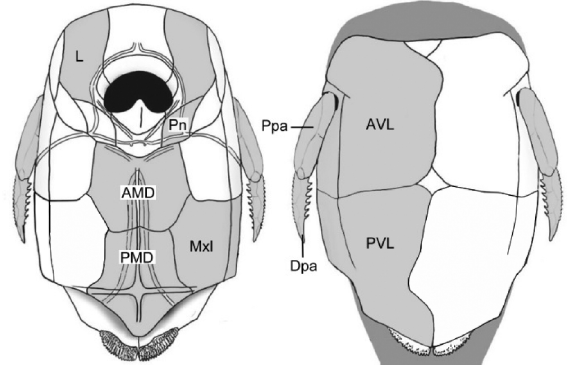
Fig. 2. Microbrachius dicki restoration (modified from Long et al. 2015, fig. 3a, b) with light grey shaded areas to indicate the known plates of Microbrachius kedoae . Abbreviations: AMD, anterior median dorsal plate; AVL, anterior ventro- lateral plate; Dpa, distal pectoral appendage; L, lateral plate; MxL, mixilateral plate; PMD, posterior median dorsal plate; Pn, paranuchal plate; Ppa, proximal pectoral appendage; PVL, posterior ventro-lateral plate.